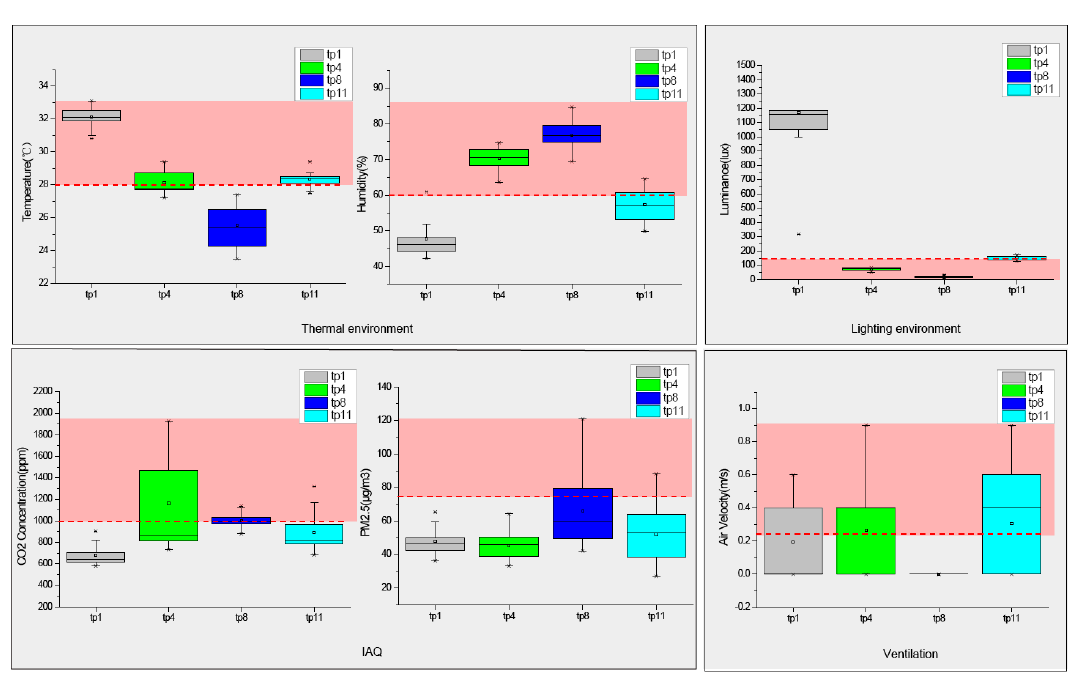
Figure 6. diagram of the physical test results from the middle tubular space.